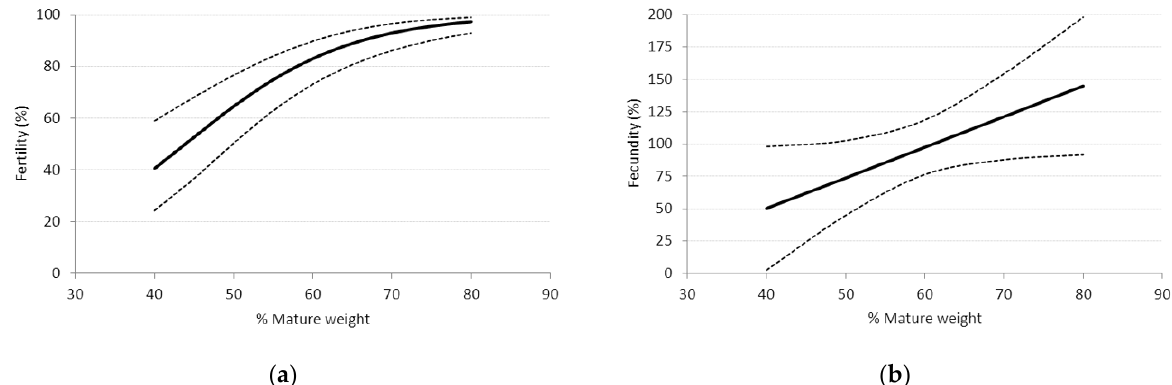
Figure 3. The relationship between percentage of mature weight and ( a ) fertility and ( b ) fecundity of 8 month old Romney crossbred ewe lambs (logit predictions and 95% confidence intervals are shown; adapted from [107] ).